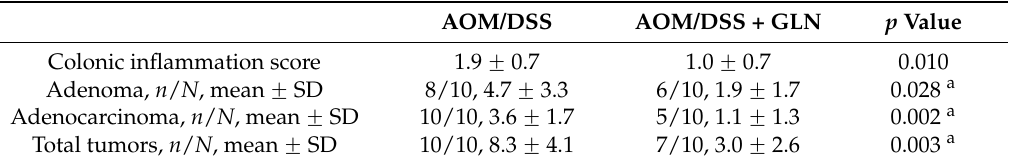
Table 1. Histological findings of colonic lesions in azoxymethane (AOM)/dextran sulfate sodium (DSS) mice and AOM/DSS mice receiving